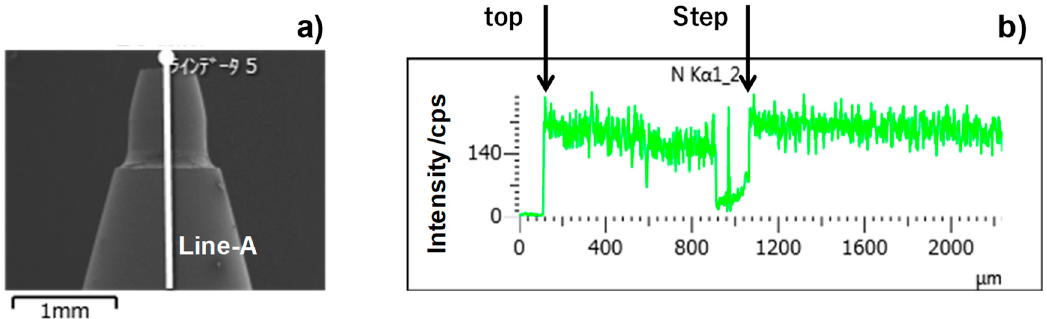
Figure 4. Plasma nitrided AISI316 micro-nozzle at 673 K for 7.2 ks. ( a ) Outlook of nitrided micro-nozzle, and, ( b ) nitrogen mapping measured from the top of the outlet down to the nozzle body.